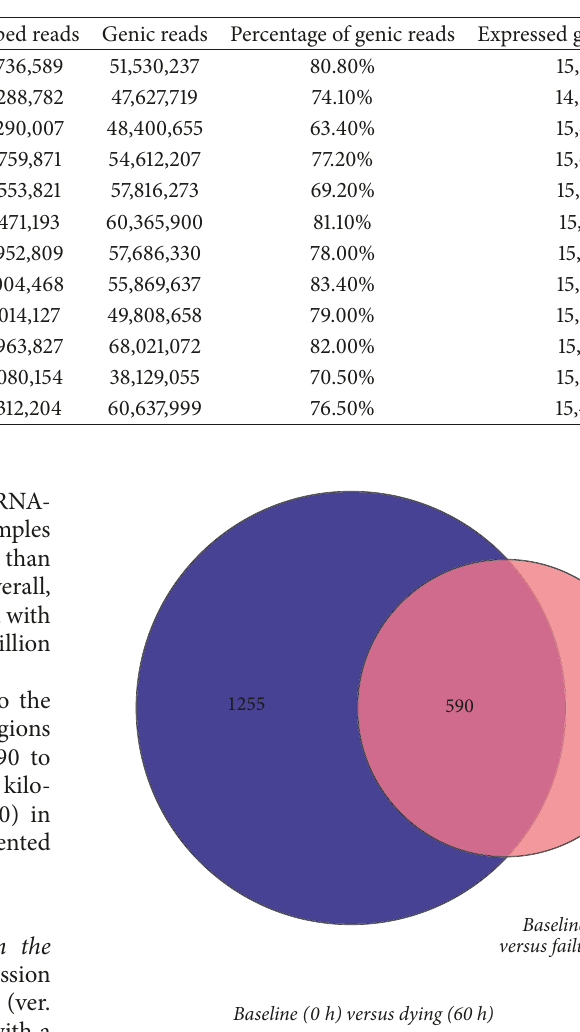
Table 2: Qualitative analysis of PBMC RNA-Seq data in a porcine model of ALF.